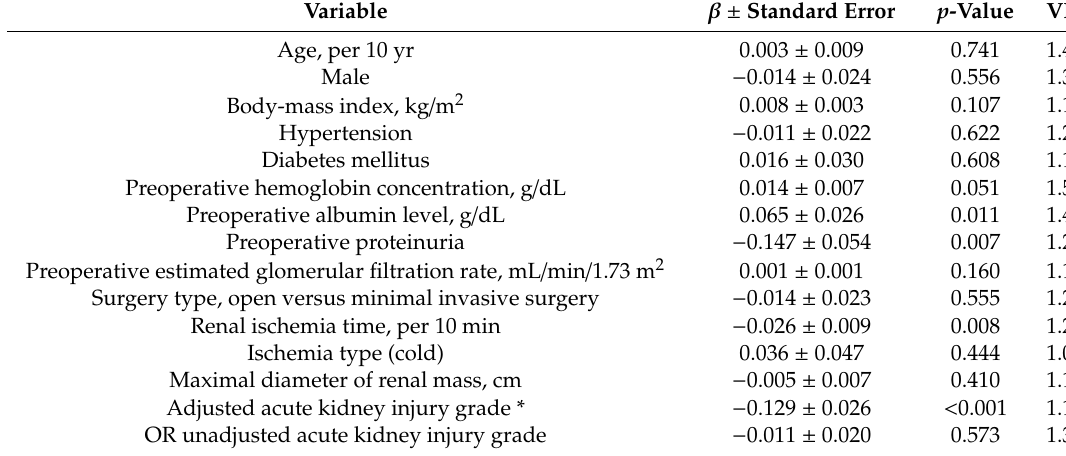
Table 2. Multivariable linear regression analysis of functional change ratio after partial